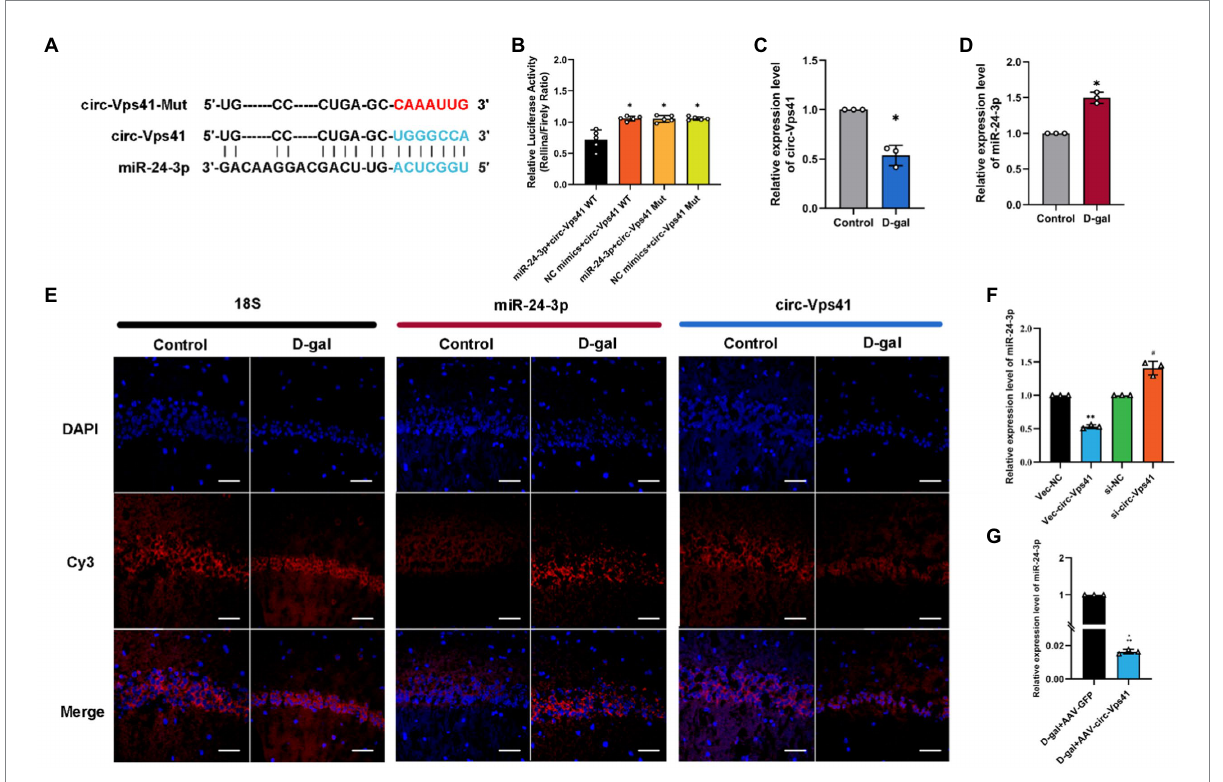
FIGURE 4 circ-Vps41 acts as a sponge of miR-24-3p. (A) Predicted binding sites of miR-24-3p in circ-Vps41; the mutation sequence is shown in red. (B) The regulatory effect of circ-Vps41 on the expression of miR-24-3p was verified by dual-luciferase reporter gene detection. (C–E) Representative FISH images of circ-Vps41, miR-24-3p, and 18S in the CA1 region of the hippocampus; Scale bars = 50 μ m. The Control group was normalized to 1. (F) The expression level of miR-24-3p was tested by qRT–PCR in HT22 cells after knockdown and overexpression of circ-Vps41. * p < 0.05, ** p < 0.01 vs. Vec-NC group; # p < 0.05 vs. si-NC group. The Vec-NC group and si-NC were normalized to 1. (G) The expression level of miR-24-3p was tested by qRT–PCR in the hippocampus of D-galactose-treated aging mice after overexpression of circ-Vps41. ( n = 3 for the D-gal + AAV-GFP group, n = 3 for the D-gal + AAV-circ-Vps41 group). The D-gal + AAV-GFP group was normalized to 1. Data are shown as the mean ± SEM. p values two-tailed t -test, one-way ANOVA. * p < 0.05, ** p < 0.01, *** p <